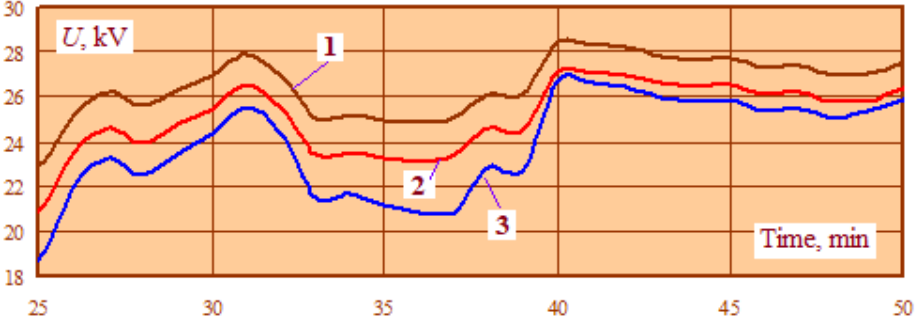
Figure 6. Voltage on the bow collector of the electric locomotive of the first train: 1 is COHL with a three - segment arrangement of conductors; 2 is COHL with a concentric arrangement of conductors; 3 is the transmission line of a conventional design with AS - 600 conductors.